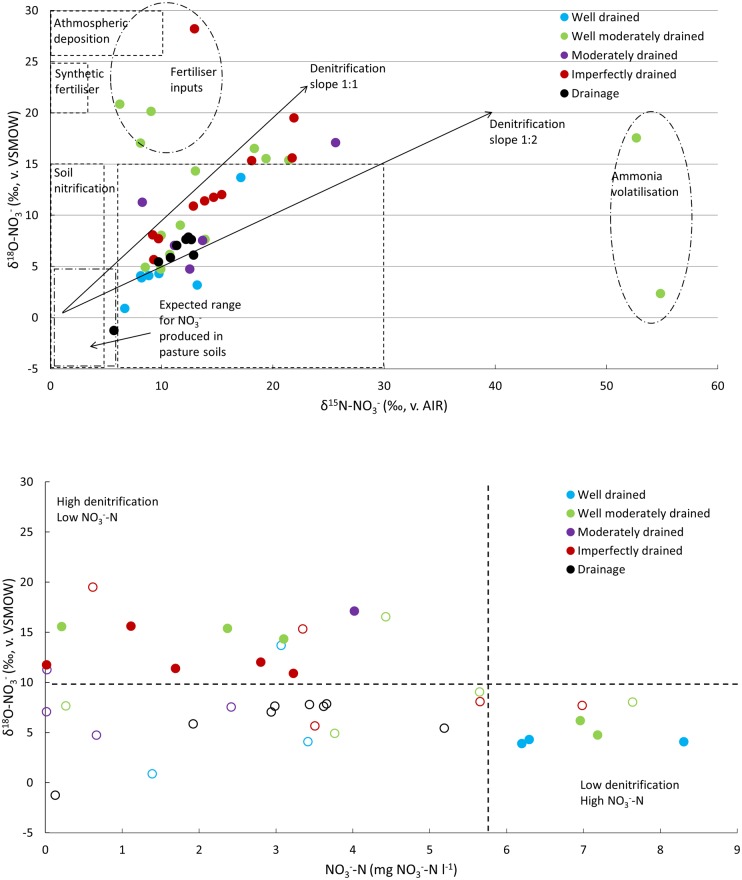
Top: scatterplot showing δ18O-NO3- vs. δ15N-NO3- for water samples collected in September 2014 superimposed onto δ18O and δ15N ranges for N-sources and processes by Yin et al. [49] and Baily et al. [14]. Bottom: scatterplot showing δ18O-NO3- vs. NO3--N values, identifying condition of inputs and denitrification rate. Whole circles identify wells with alternatively 1) NO3--N concentration <5.65 mg NO3--N l-1 and high denitrification isotope signature (>10‰) i.e. exhibiting excess inputs of NO3--N that has been denitrified or 2) NO3--N >5.65 mg NO3--N l-1 and low denitrification isotopic signature (<10‰) i.e. exhibiting contamination due to an insufficient rate of denitrification. Open circles identify wells that were discarded due to depth or where the NO3--N concentration was <5.65 mg NO3--N l-1 in combination with a low denitrification isotopic signature (<10‰), i.e. exhibiting a situation of limited denitrification and low inputs.